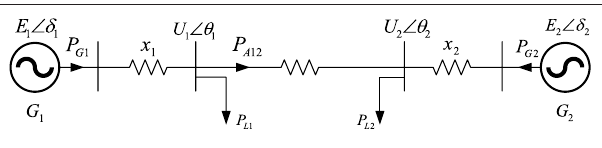
FIGURE 1 | AC system equivalent